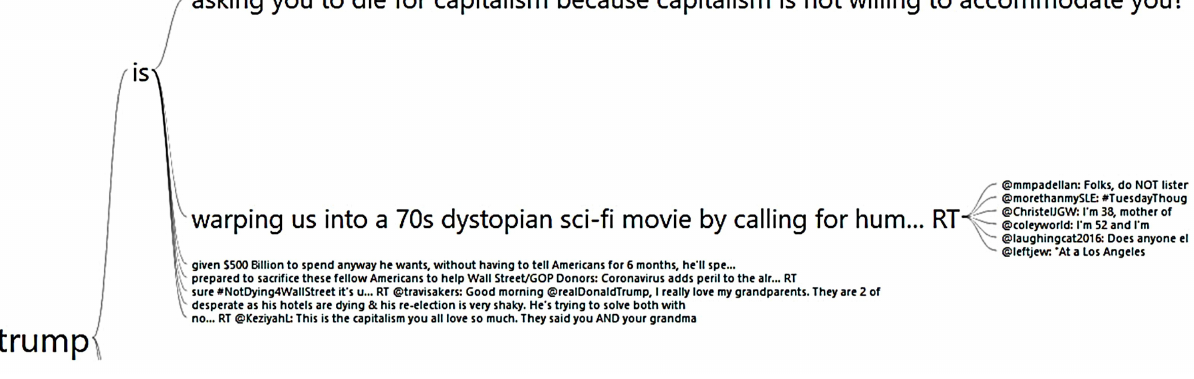
Figure 4. Word tree with ‘Trump’ and its concordances (MAXQDA